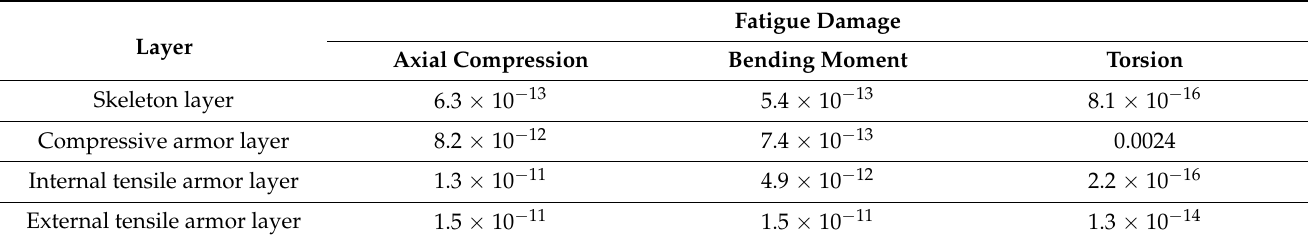
Table 3. The maximum fatigue damage under the three